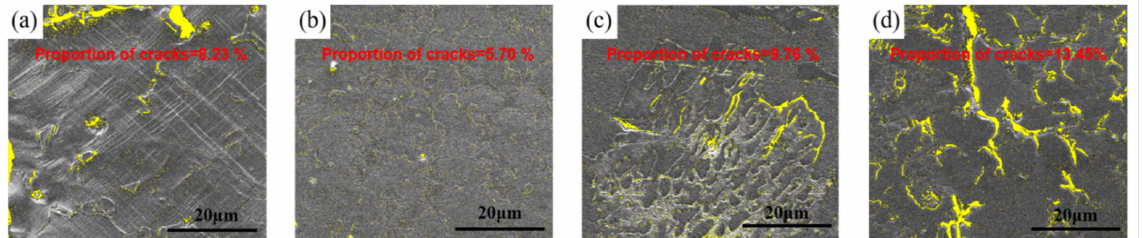
Figure 13. The crack distribution and proportion of cracks in Fe-25Mn- x Al-8Ni-C alloys with different Al contents at the moment of fracture during in situ tension, ( a ) 10 wt.% Al; ( b ) 11 wt.% Al; ( c ) 12 wt.% Al; ( d ) 13 wt.%